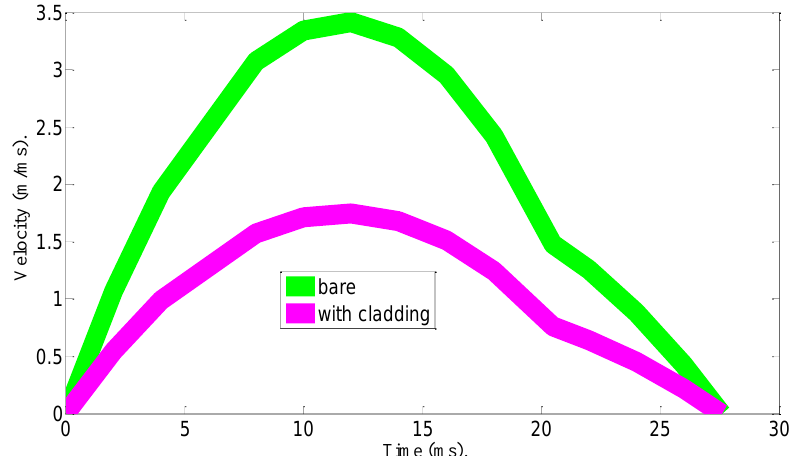
(b): Response of blast load on front wall alongvelocity with and without cladding material.